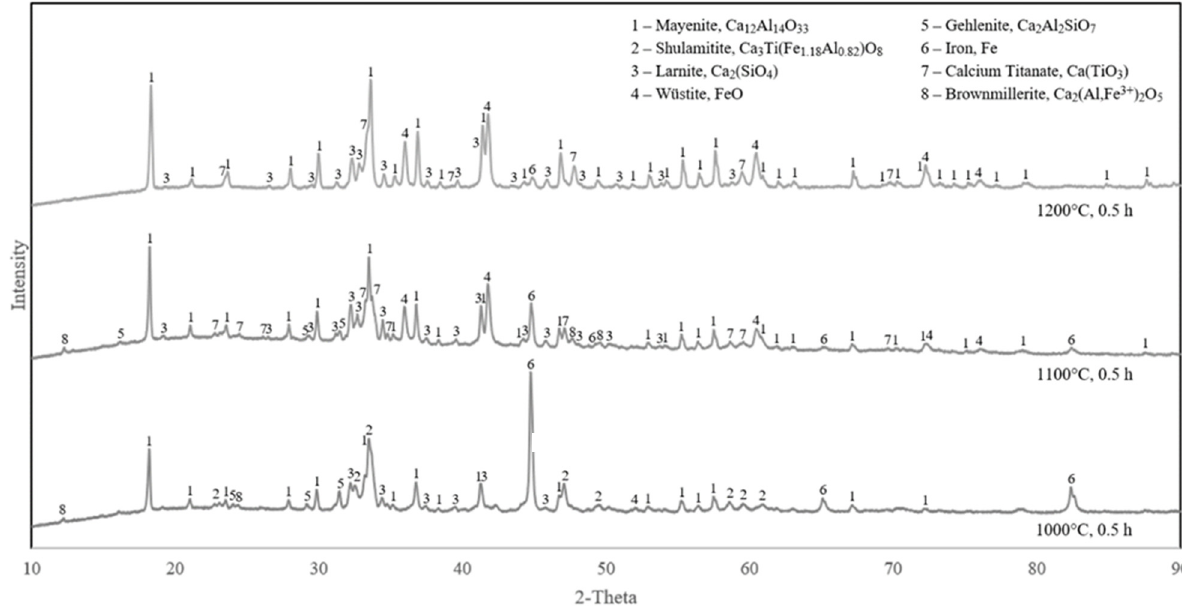
Figure 4. XRD analyses of samples reduced for 0.5 h at different temperatures (samples 1, 5, 8).